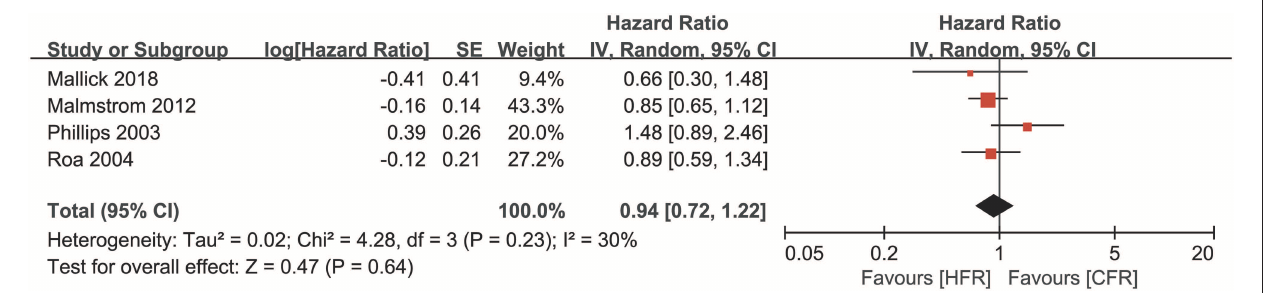
Frontiers in Oncology |